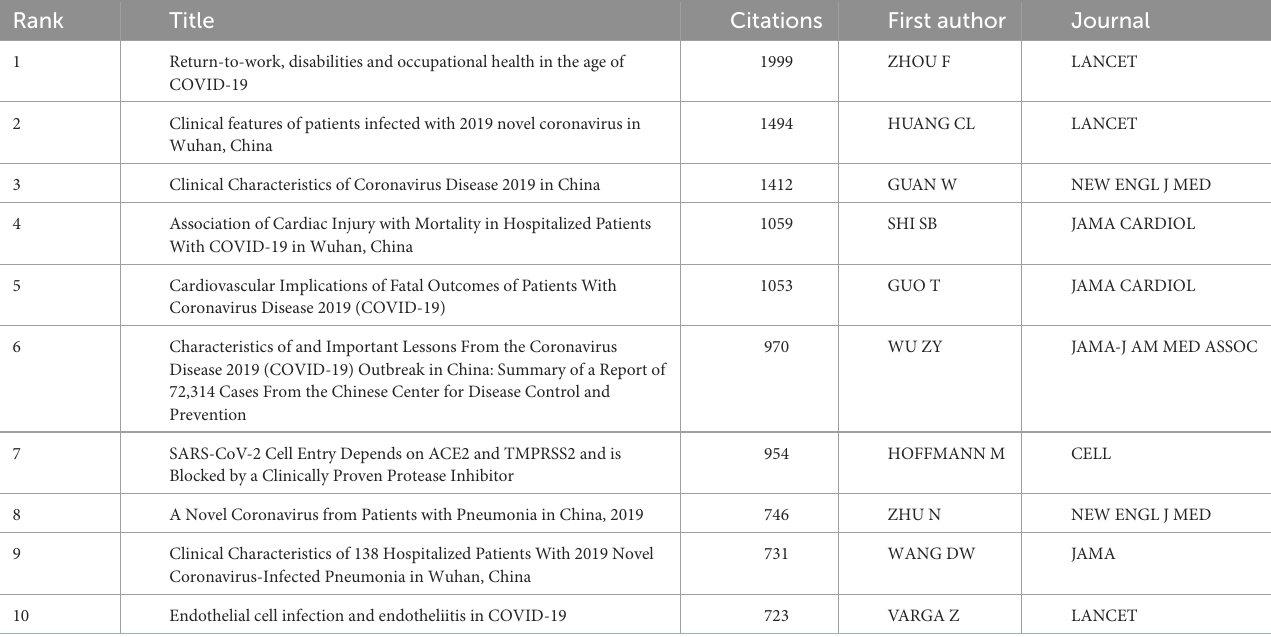
TABLE 6 Top 10 co-cited references in COVID-19-related CVD